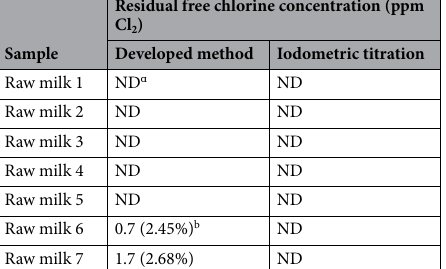
Table 3. Determination of liquid bleach adulteration in milk samples using the developed method (n = 3). ɑ Not detected. b Coefficient of variation.